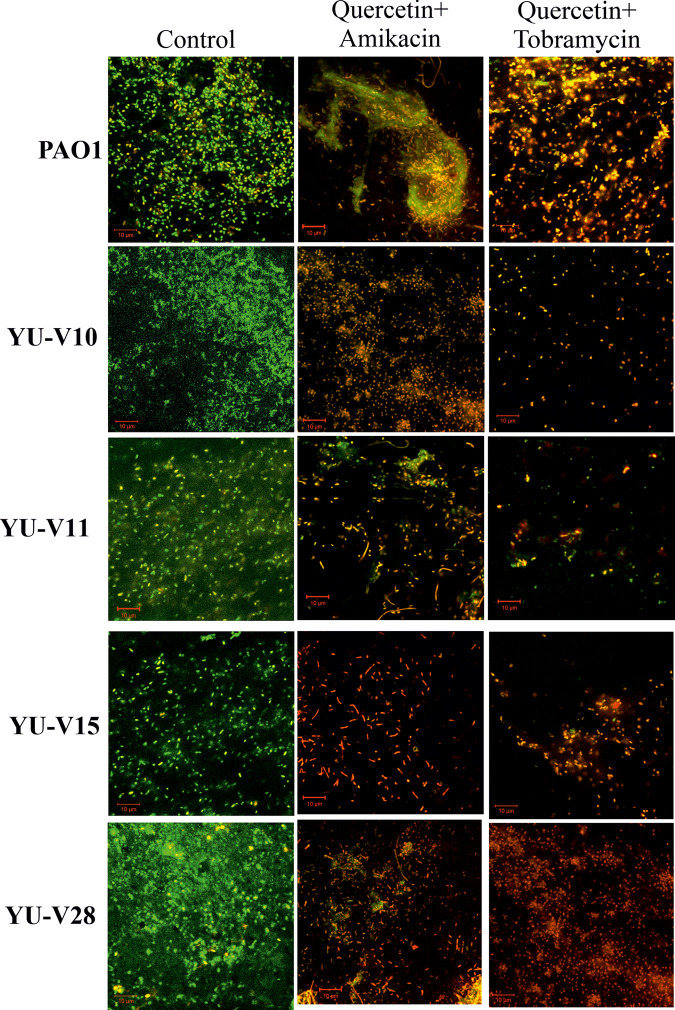
Biofilm viability as visualized by live/dead staining for P. aeruginosa (YU-V10, YU-V28, YU-V11, YU-V15 PAO1) using CLSM.(a) PAO1, YU-V10, YU-V28 and (b) YU-V11 and YU-V15. The biofilms were treated with quercetin and antibiotics at the lowest FICi combination and stained with Acridine Orange-Propidium Iodide staining. Green color indicates the live cells and yellow to red color indicates dead cells.